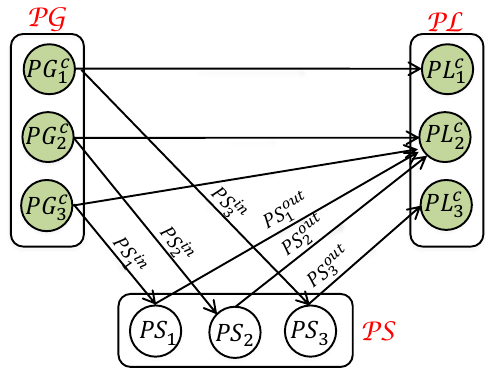
Figure 9. Power system considered in this paper.